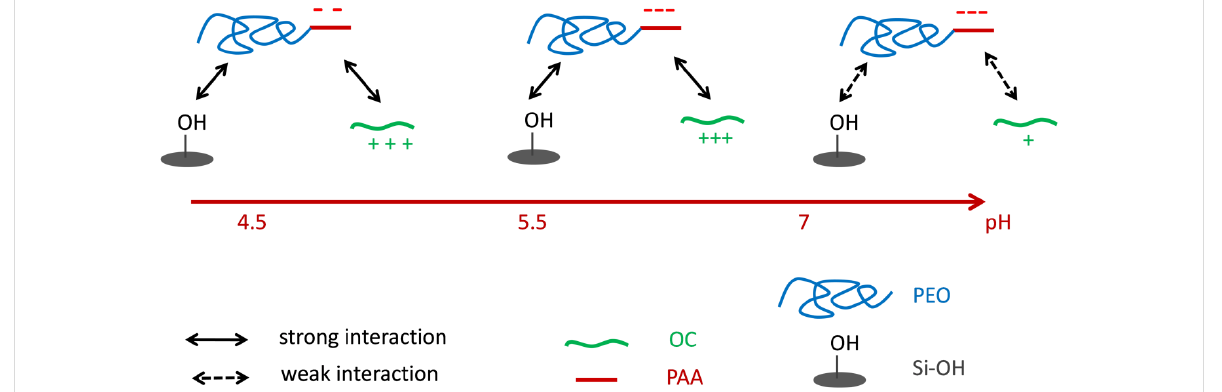
Figure 6: Schematic representation of the interactions between silicic species and PEO, OC and PAA entities as a function of pH.